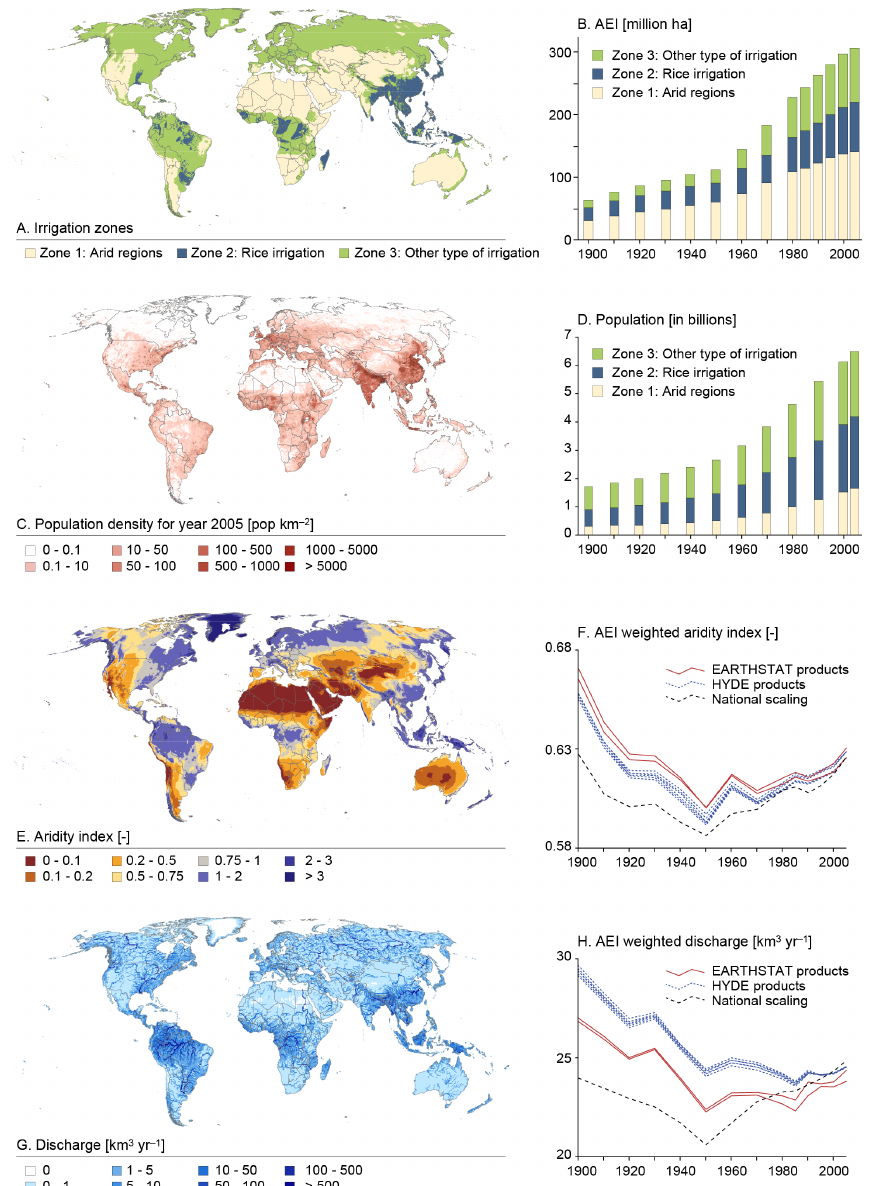
Figure 4. (a) Classification of irrigation areas in dry areas, wet rice cultivation areas, and other wet irrigation areas and (b) development of global AEI for historical irrigation data set (HID; AEI_HYDE_FINAL_IR) in these zones for the period 1900–2005; (c) population density for year 2005 according to the HYDE database (Klein Goldewijk et al., 2010) and (d) number of people in the three different irrigation zones in the period 1900–2005; (e) aridity index according to the CGIAR-CSI Global Aridity and ET database (CGIAR-CSI, 2014; Zorner et al., 2008) and (f) change in mean aridity on irrigated land in the period 1900–2005; (g) mean annual river discharge in the period 1961–1990 calculated with WaterGAP 2.2 (Müller Schmied et al., 2014) and (h) change in global mean of natural river discharge on irrigated land in the period